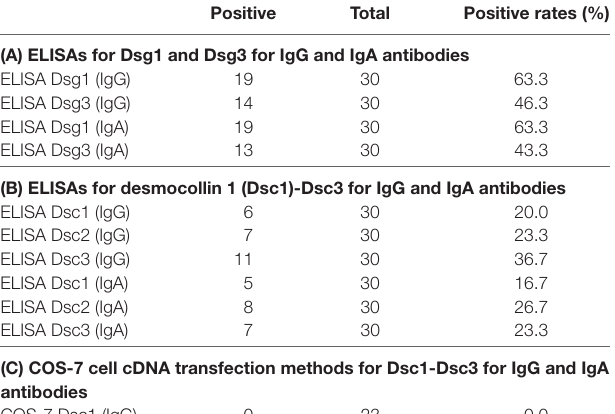
taBLe 2 | Results of various ELISAs and COS7 cell cDNA transfection.